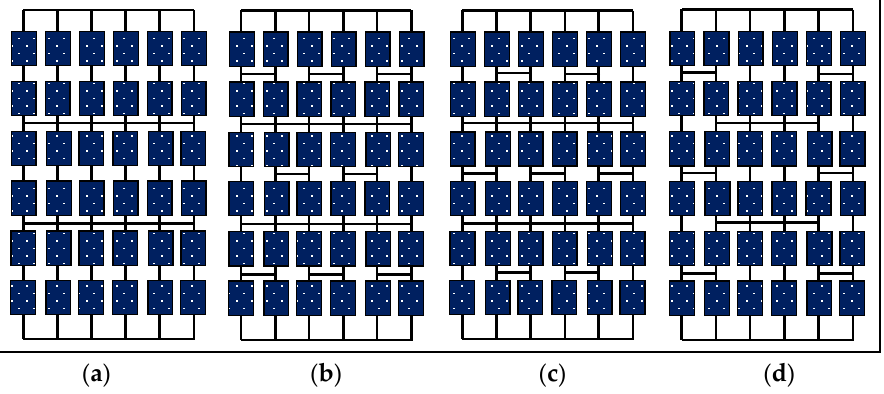
Figure 3. Hybrid configurations for 6 × 6 PV array. ( a ) SP-TCT, ( b ) BL-TCT, ( c ) HC-TCT, and ( d ) BL- HC.